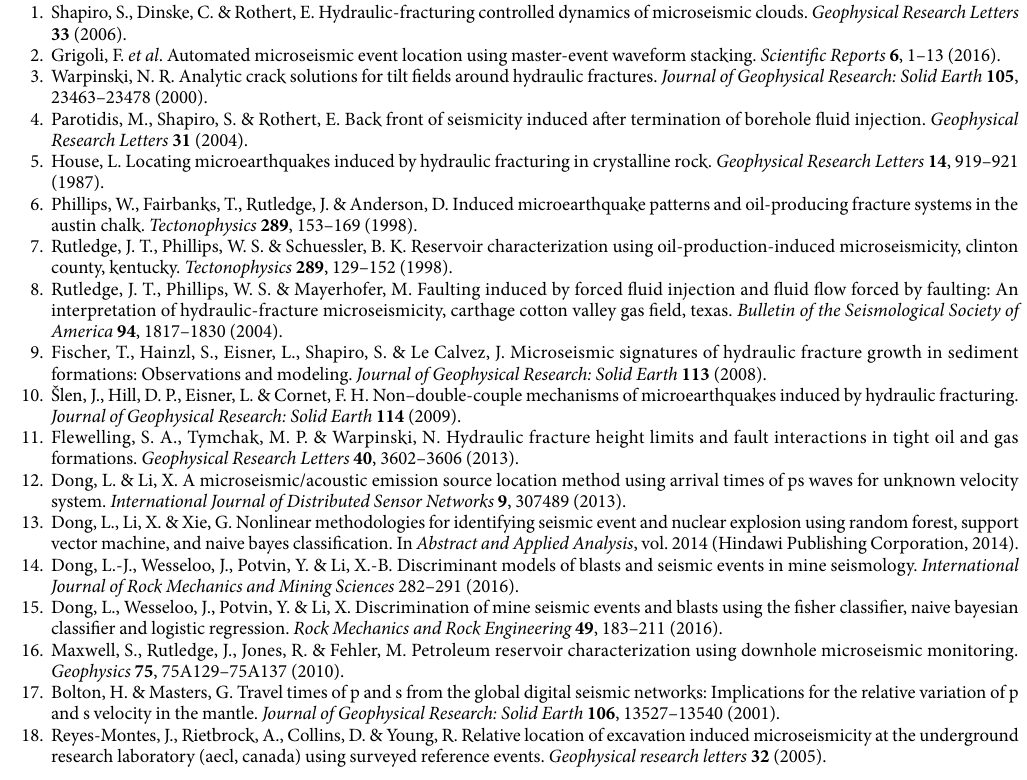
the recorded data is extremely noisy and microseismic signals are very weak. The proposed orthogonalized mor- phological reconstruction method belongs to a class of single-channel techniques and does not require array data. It can be used not only in microseismic monitoring, but also in other type of seismic data (active source or earthquake data), and in other real world applications, e.g., image processing and signal processing, large-scale earthquake data processing and inversion. The proposed method is promising for a wide research community and industrial applications.